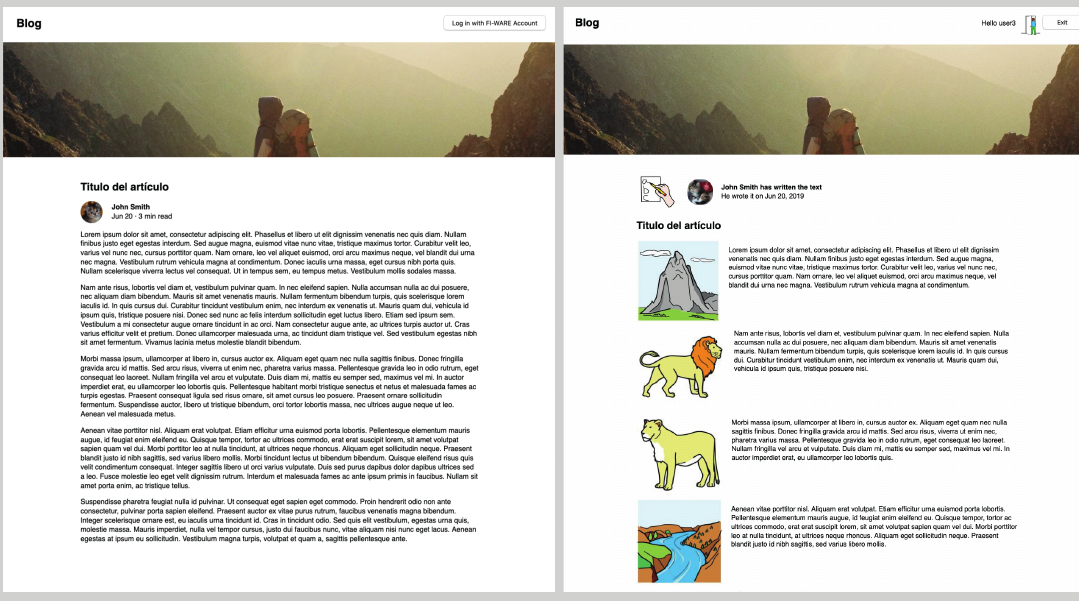
Figure 9. Log In Interface ( left ) & Interface 2 ( right